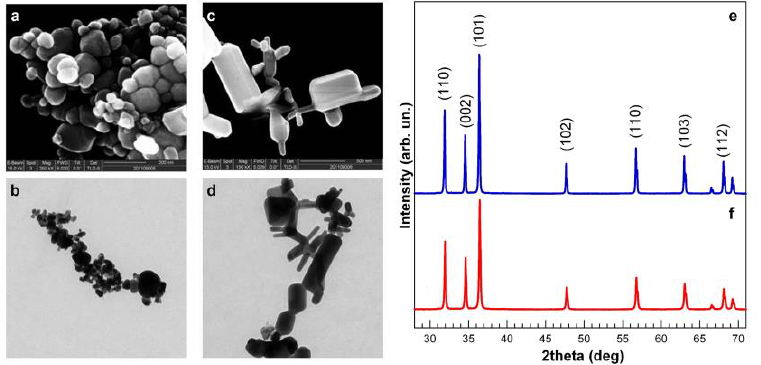
Figure 1. Physical and chemical characterization of ZnO nanoparticles. SEM and TEM images of sZnO (smaller, round) ( a , b ) and bZnO (bigger, rod) ( c , d ). XRD analysis of dry sZnO ( e ) and bZnO ( f ); the main planes for zincite crystal are